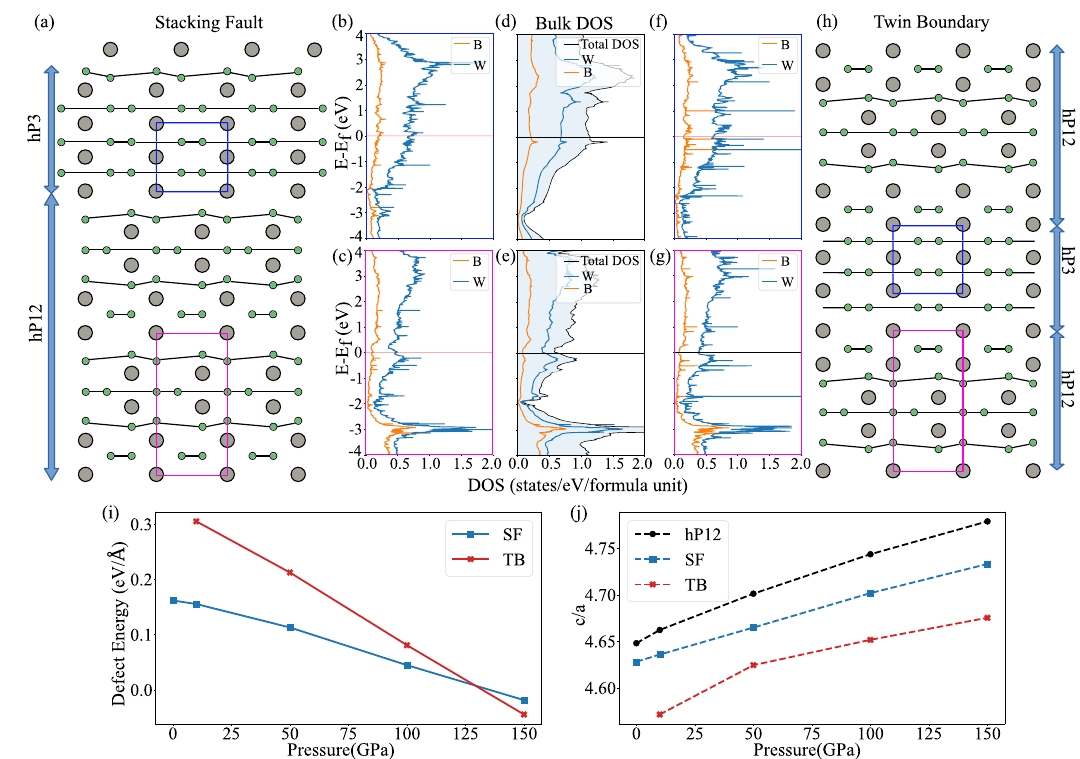
Fig. 4 | Summary ofpressure dependentproperties ofstacking faults and twin boundariesin WB 2 . a Stacking faults and h twin boundaries in the hP12phase;the stacking of atomic planes along the c axis at the defect mirrors the stacking in the hP3 phase. Green and gray circles represent boron and tungsten, respectively. b , c , f , g projected DOS for the stacking faults and twin boundary. The DOS was spatially projected on the hP3 and hP12 parts of the defect structures. d , e DOS of